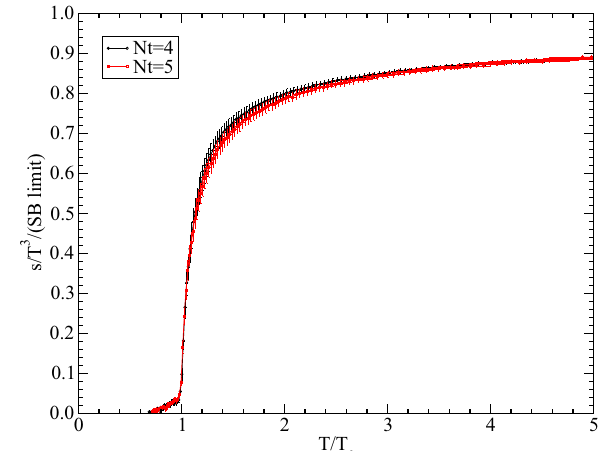
Fig. 16 Entropy density s normalised to the SB limit